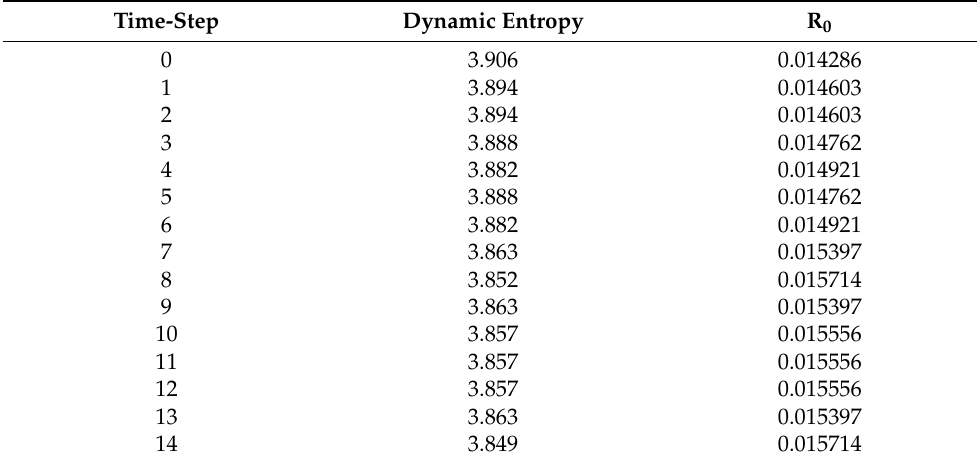
Figure 8. Dynamic entropy ( left ) and R 0 measures ( right ) of the generated small world network. Table 7. Temporal evolution of entropy and R 0 values for the generated small world network